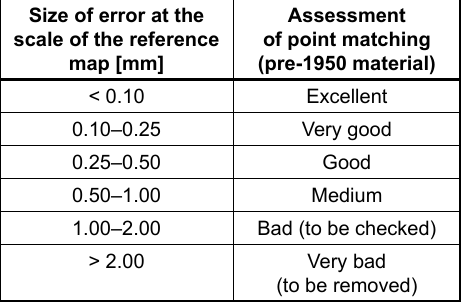
Table 1. Interpretation of the estimation error against the offset value on the analogue material Assessment Size of error at the of point matching scale of the reference (pre-1950 material) map [mm] <